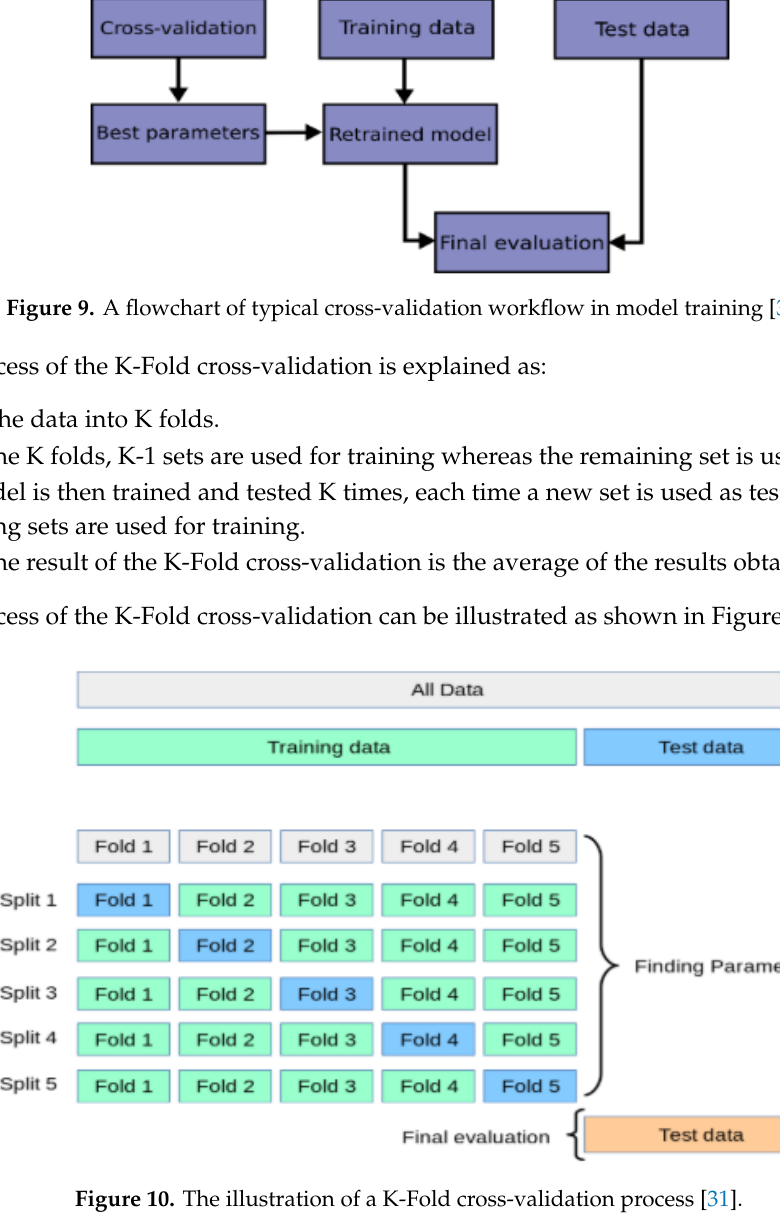
Figure 10. The illustration of a K-Fold cross-validation process [31].